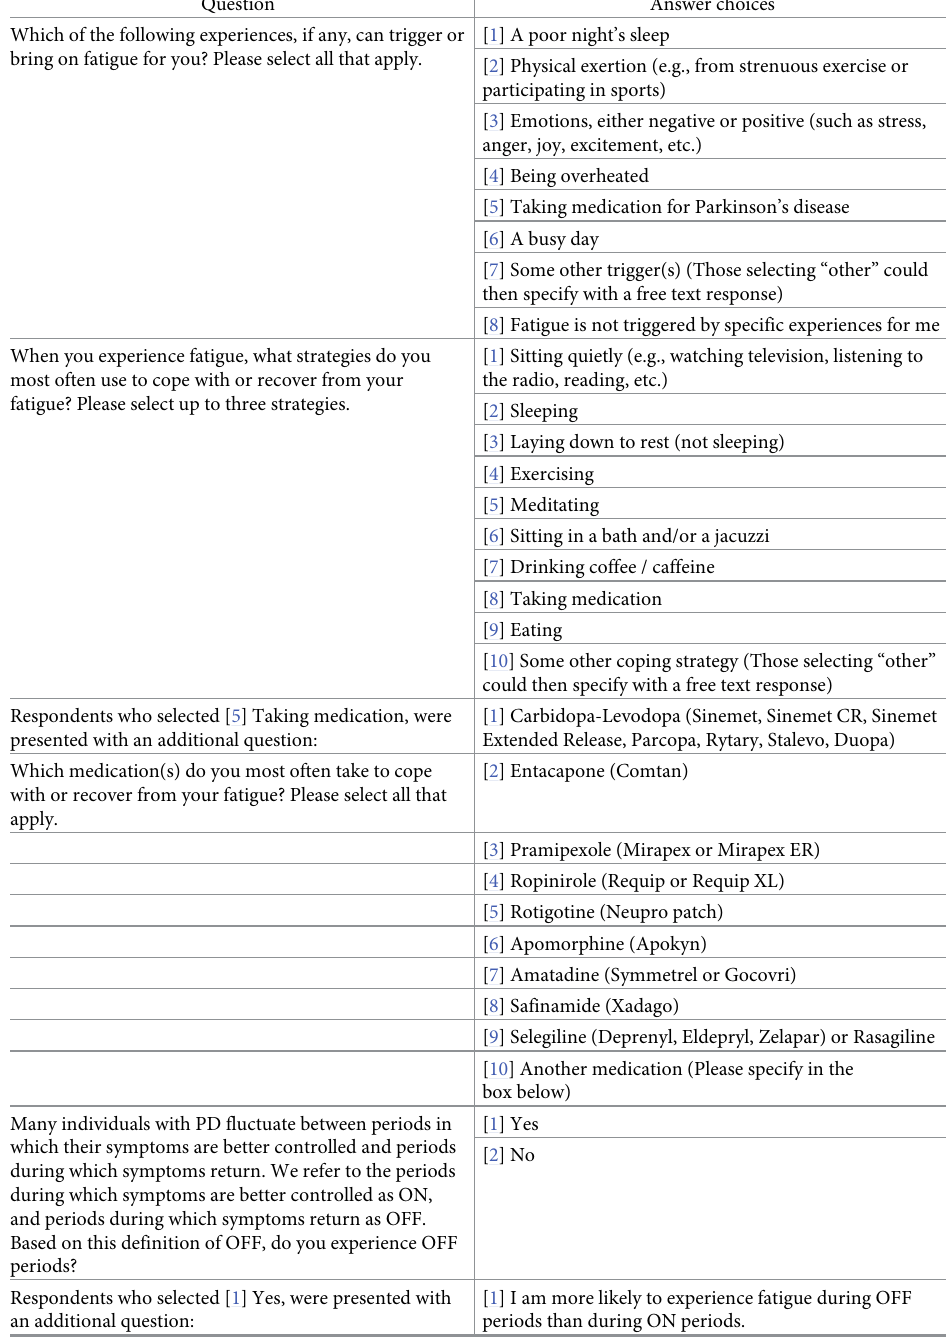
Table 1. Fatigue survey